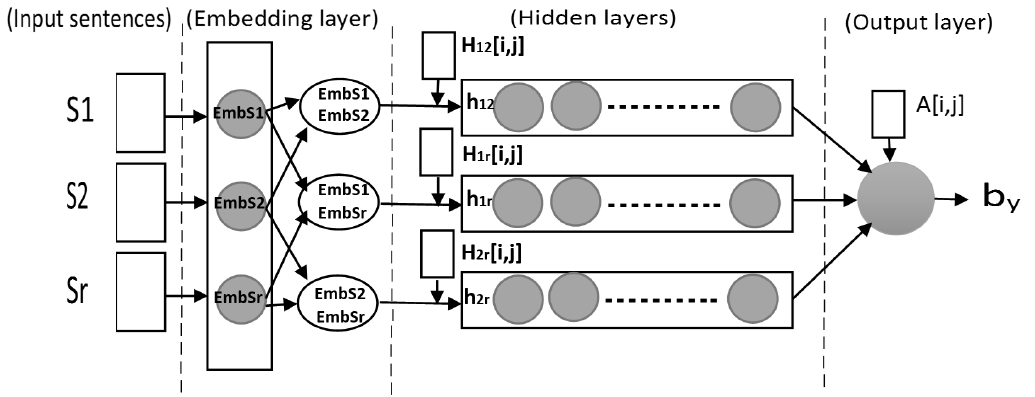
Figure 1. Neural network (NN)